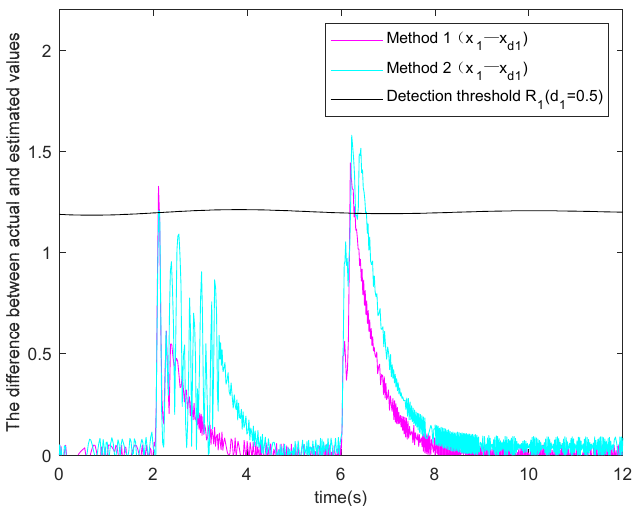
Figure 8. The fault-tolerant control function of subsystem 1 under two fault conditions.